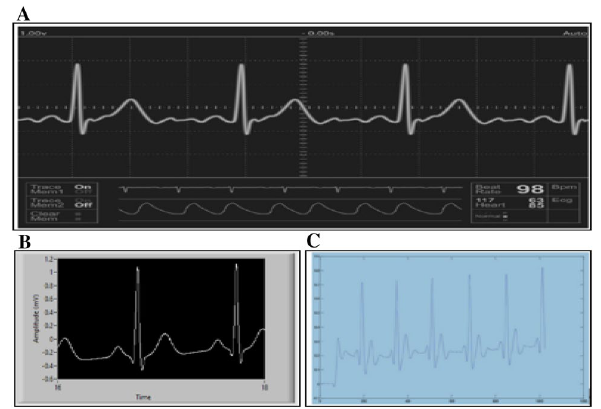
Fig. 20 The validation results a the data generated by the existing ECG machine, b the results of real time ECG monitoring system [17], c the results of developed ECG monitoring system